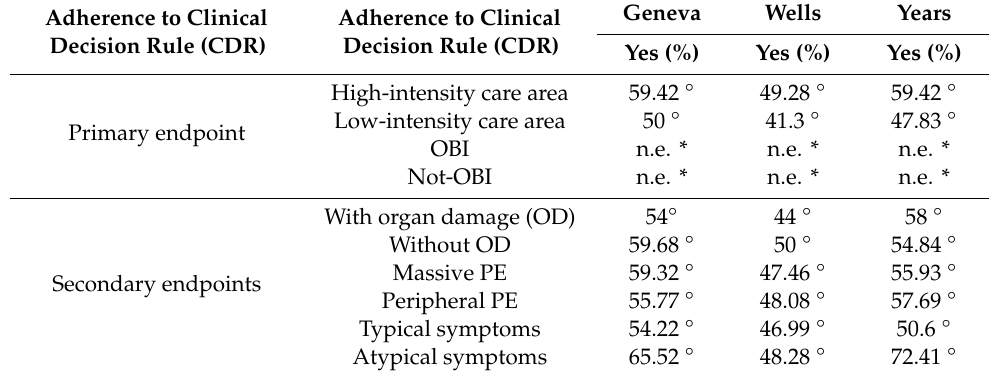
Table 2. Adherence to clinical decision rule (CDR). At the top, the analytic subgroups for the primary outcome. Below, the subgroups analyzed in the secondary outcomes.